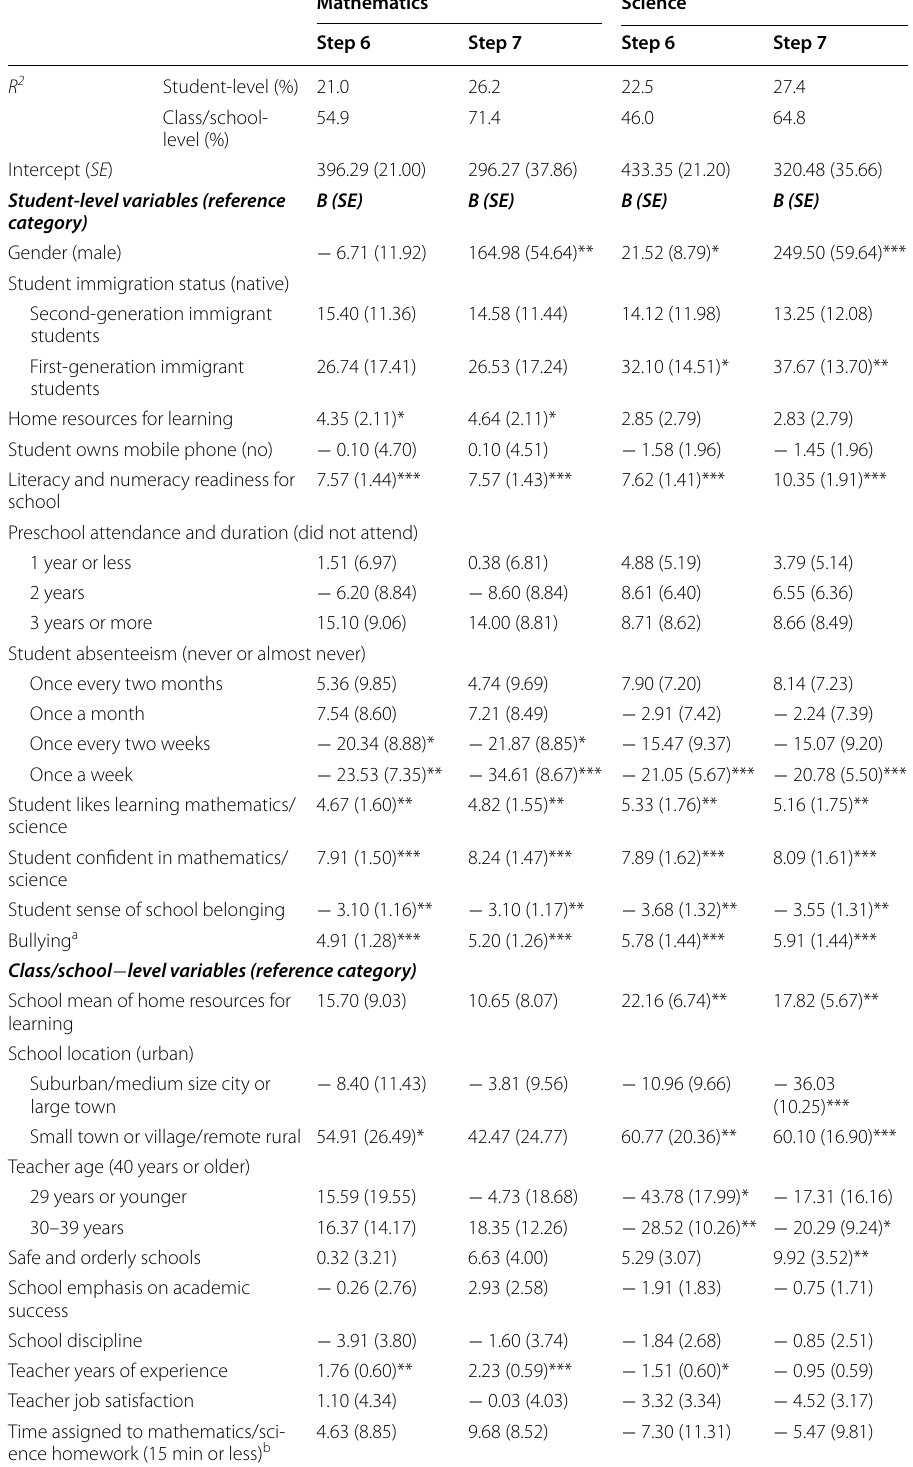
Table 10 Steps 6 and 7 from the hierarchical two‑level linear regression models for mathematics and science achievement, grade 4, TIMSS